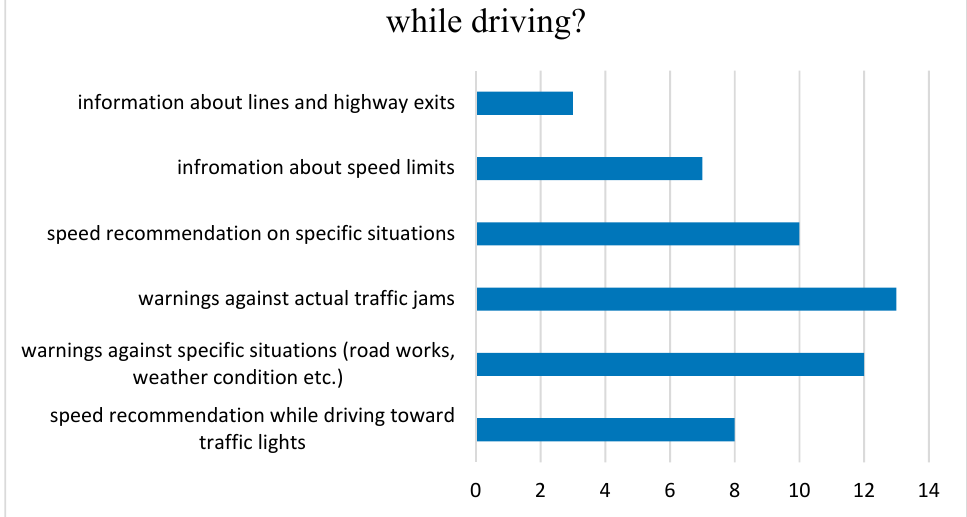
Figure 6. Types of information that drivers would welcome while driving.